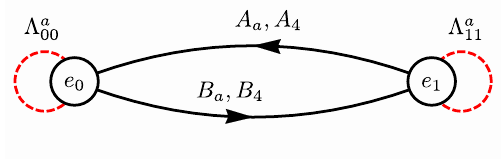
Figure 1 . The C 2 = Z 2 (1 ; 1 ; 1 ; 1) quiver. The index a takes the values a = 1 ; 2 ; 3. There are three adjoint fermi multiplets (cid:3) a at each nodes, and two sets of four chiral multiplets, A i = ( A a ; A 4 ) and B i = ( B a ; B 4 ), in bifundamental representations. The quiver arrows have multiplicities equal to the number of distinct chiral or fermi